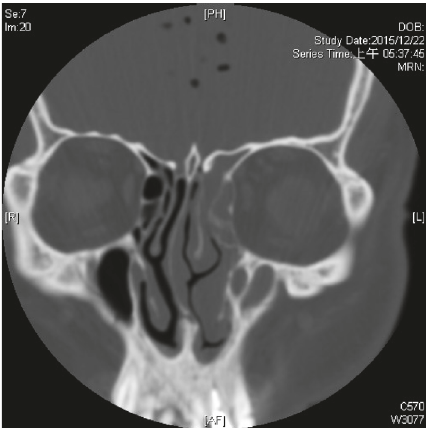
Figure 2: The transverse view of the CT scan shows air accumula- tion in the subarachnoid space indicating a